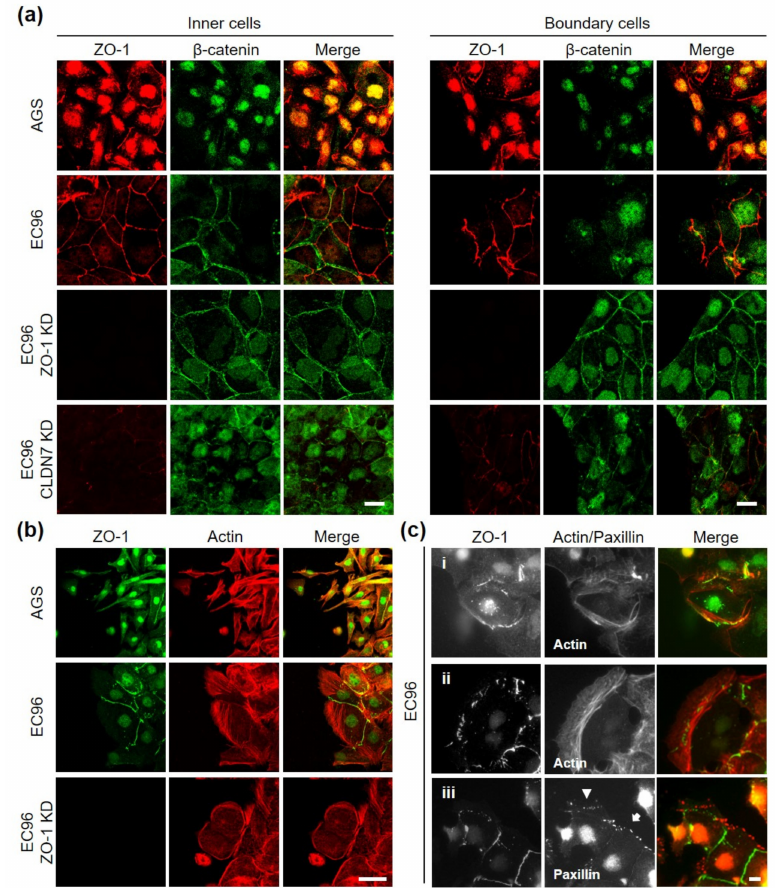
Figure 5. Analysis of differential expression of ZO-1 protein in migratory cells. ( a ) Double- immunofluorescence labeling for β -catenin (green) and ZO-1 (red) in inner cells (left panel) and boundary cells (right panel) of AGS, EC96, and ZO-1-knockdown EC96 cells. Scale bar: 100 µ m. ( b ) AGS, EC96, and ZO-1-knockdown EC96 cells were subjected to immunofluorescence staining for ZO-1 (green) and Actin (red) at the leading edge. Scale bar: 100 µ m. ( c ) EC96 cells were subjected to double-immunofluorescence labeling for ZO-1/Actin (c-i) and (c-ii) or ZO-1/Paxillin (c-iii) at the leading edge. Scale bar: 100 µ